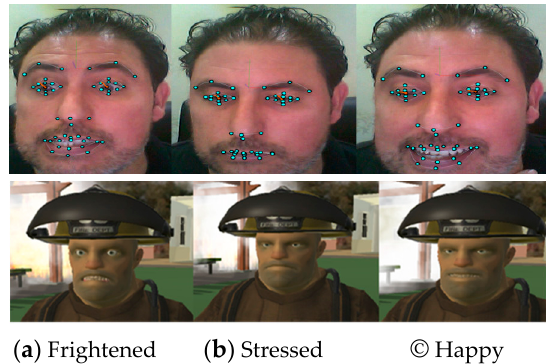
Figure 14. XML file for face control.